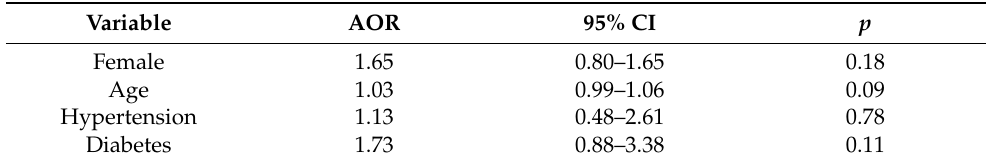
Table 4. Multivariate regression model of independent factors for severe AKI among patients with